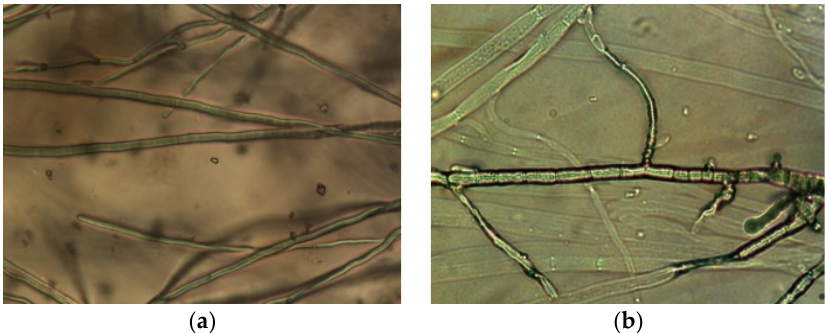
Figure 3. F. graminearum BZR 4 hyphae in control without antagonist ( a ) and in co-cultivation with B. velezensis BZR 336 g ( b ), ×200 magnification.